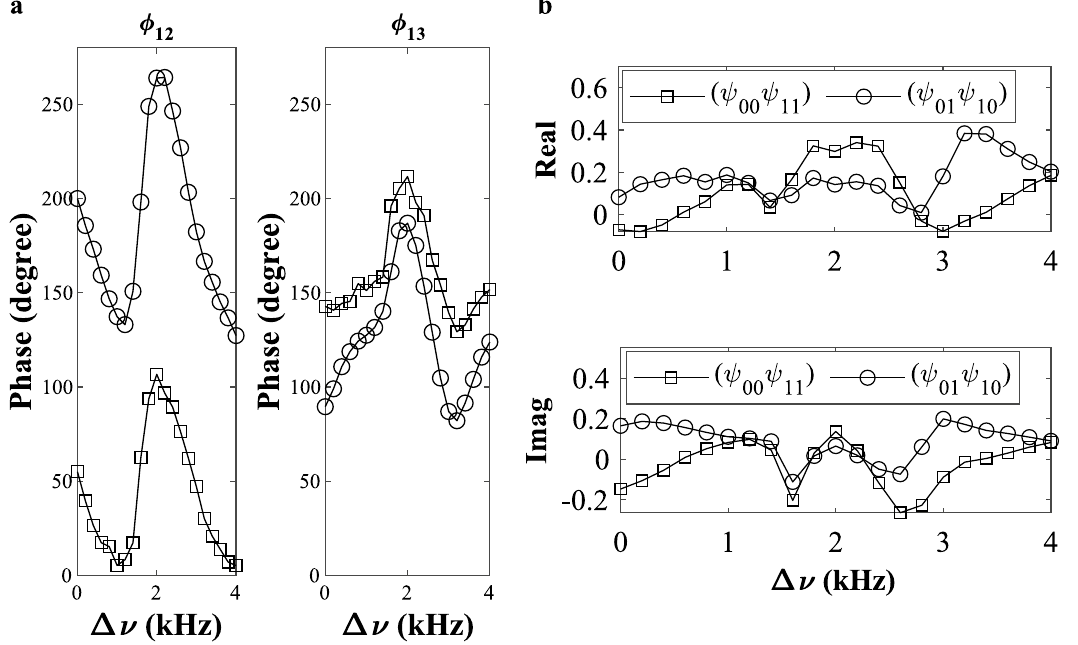
Figure 2. Nonseparability of N = 2 phi-bits. ( a ) Experimental phase differences between the coupled waveguides ( ϕ 12 and ϕ 13 ) for the two logical phi-bits (9, 15). In the plot, open circle corresponds to ϕ